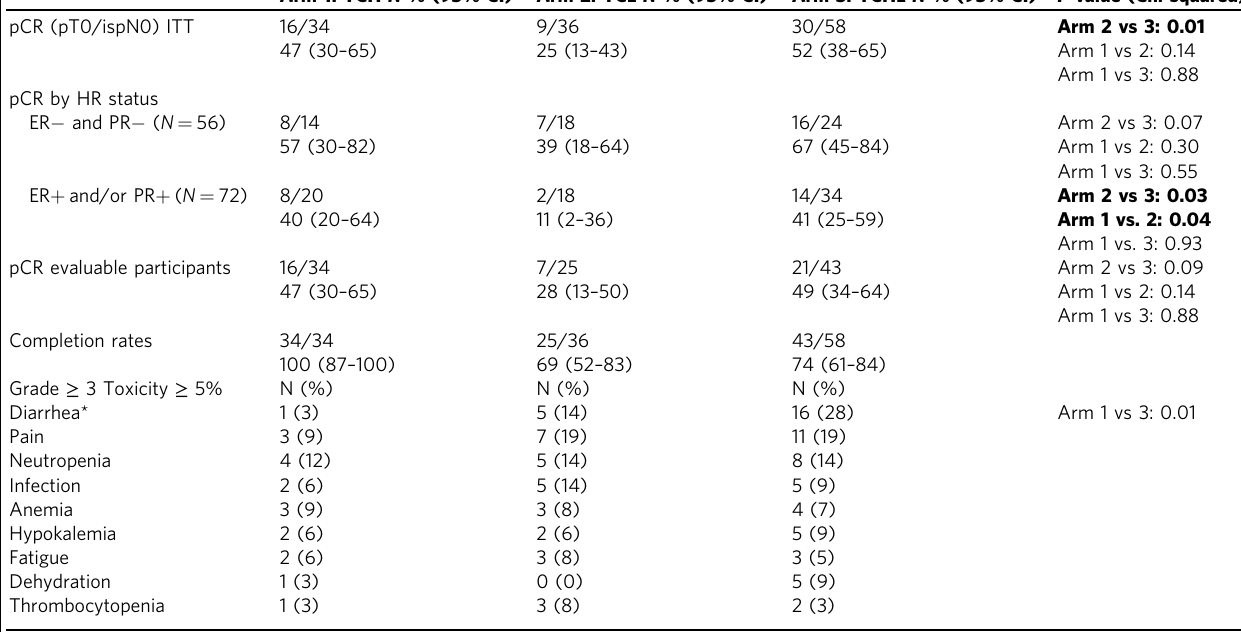
Table 2 Pathologic complete response rates and